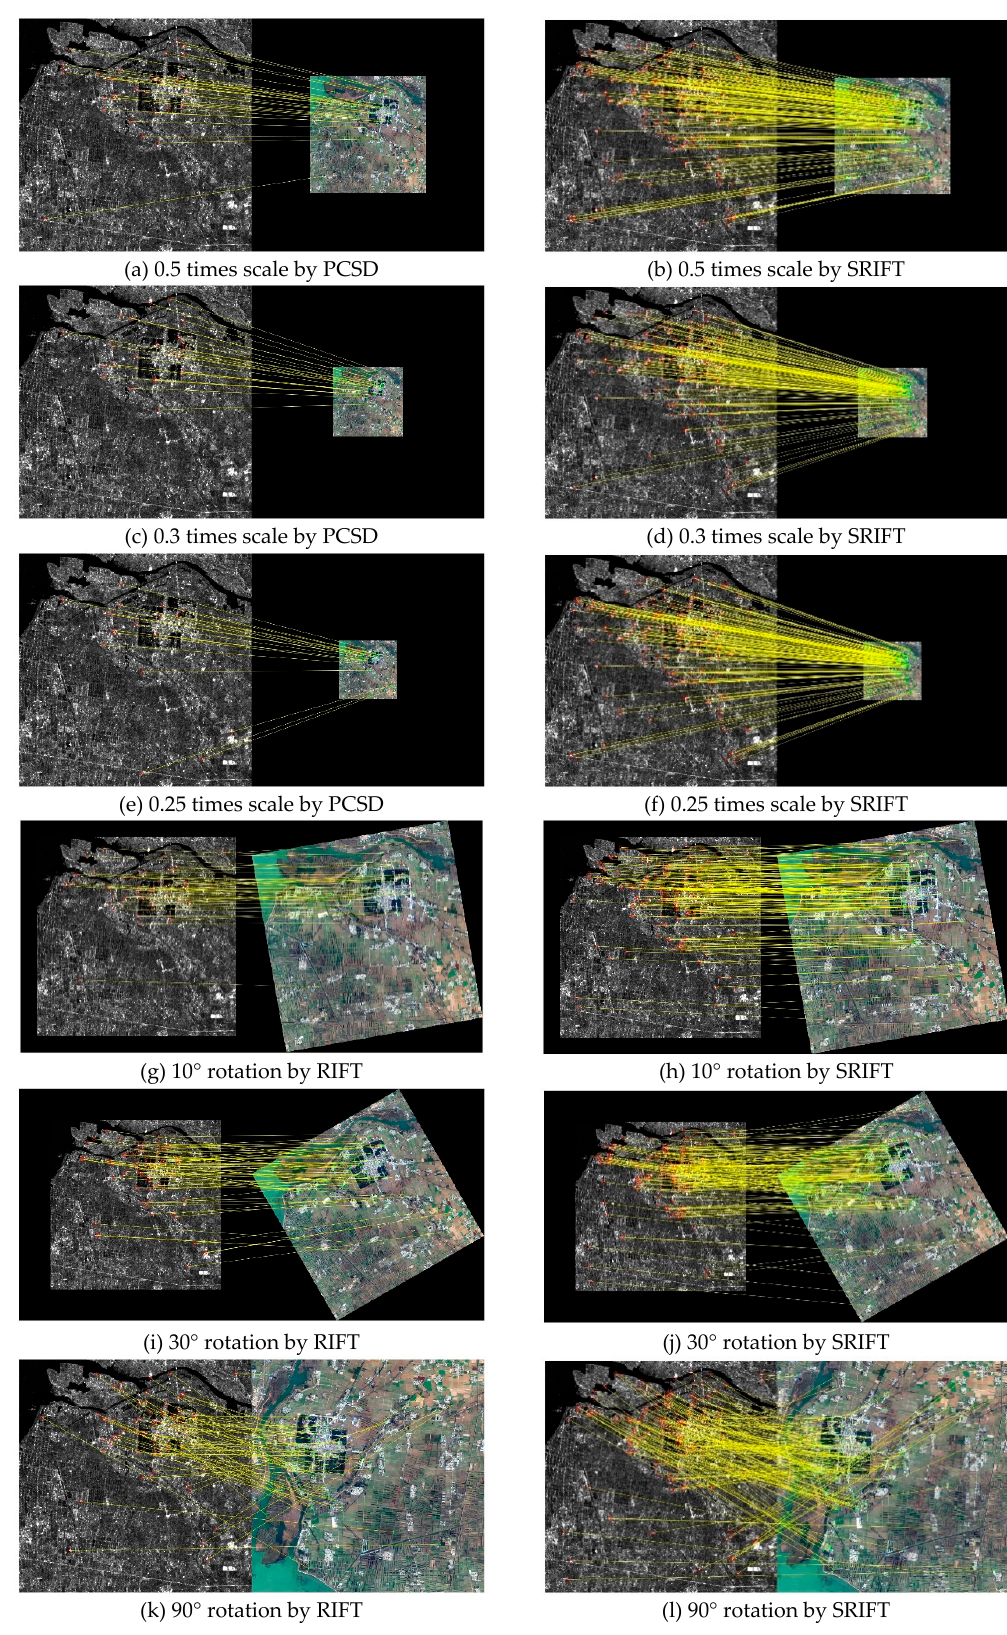
Figure 7. The simulated experiment results for the Sentinel-1 and Sentinel-2 images.